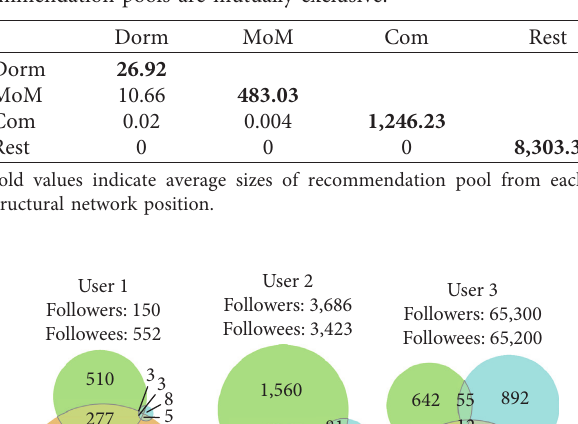
Table 2: 26 potential recommendations from the Dorm group, 483 from MoM, and 1,246 from Com for an average targeted Twitter user. Intersections of each group are insignificant, meaning rec- ommendation pools are mutually exclusive.